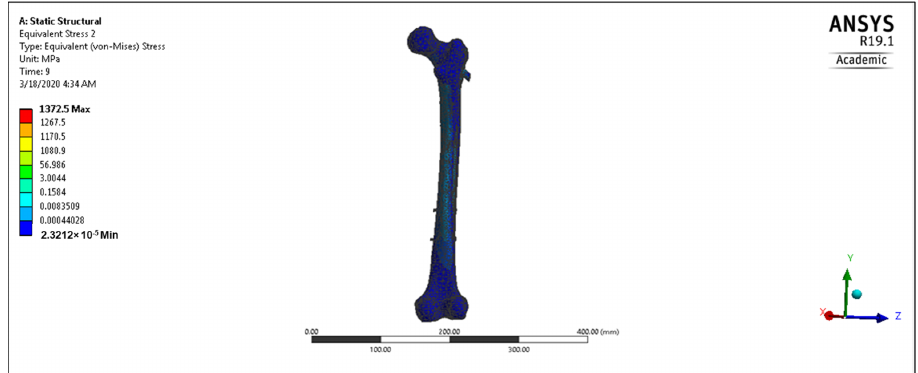
Figure 19 . Grain size ( μ m) with respect to area fraction.